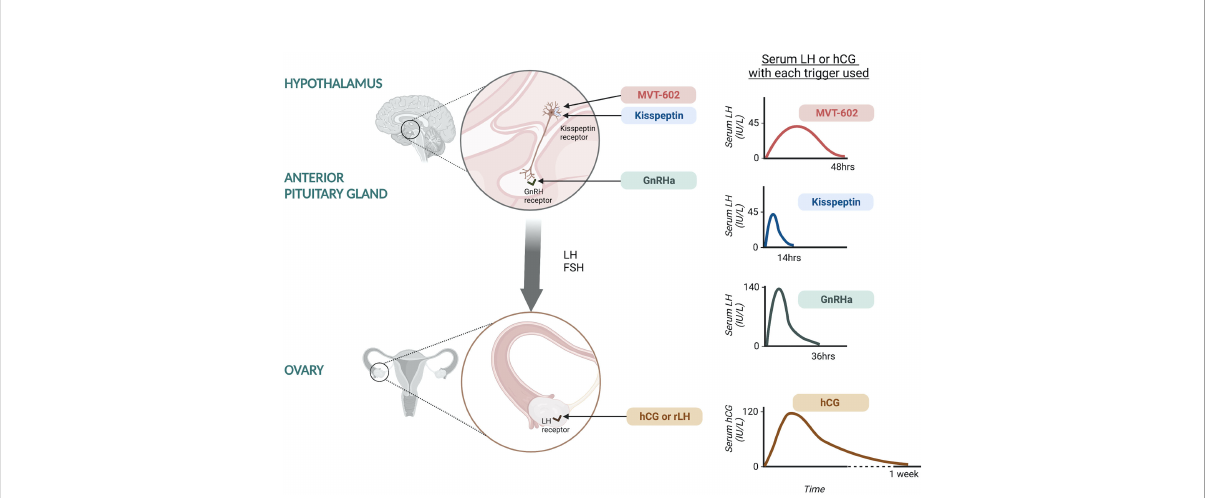
FIGURE 1 Site of action of oocyte maturation triggers during IVF treatment and the resultant serum LH or hCG response. Kisspeptin and MVT-602 act at the level of the hypothalamus to stimulate kisspeptin receptors on GnRH neurons leading to GnRH release. Kisspeptin induces a peak LH rise of ~45 IU/L at ~5 hours following administration, returning to pre-trigger levels at 12-14 hours. MVT-602 induces a peak of LH rise of similar amplitude to that of the native peptide, KP54, however the duration of the LH rise was markedly prolonged, time of peak LH ~21-22 hours. GnRHa acts at the level of the anterior pituitary on GnRH receptors to stimulate endogenous LH and FSH secretion. GnRHa induces a peak LH level of 140.4 IU/L at ~4 hours after administration. hCG and rLH act at the level of the ovary, directly at the LH receptors. hCG induces a peak hCG level of 121.0 IU/L occurring 24 hours after